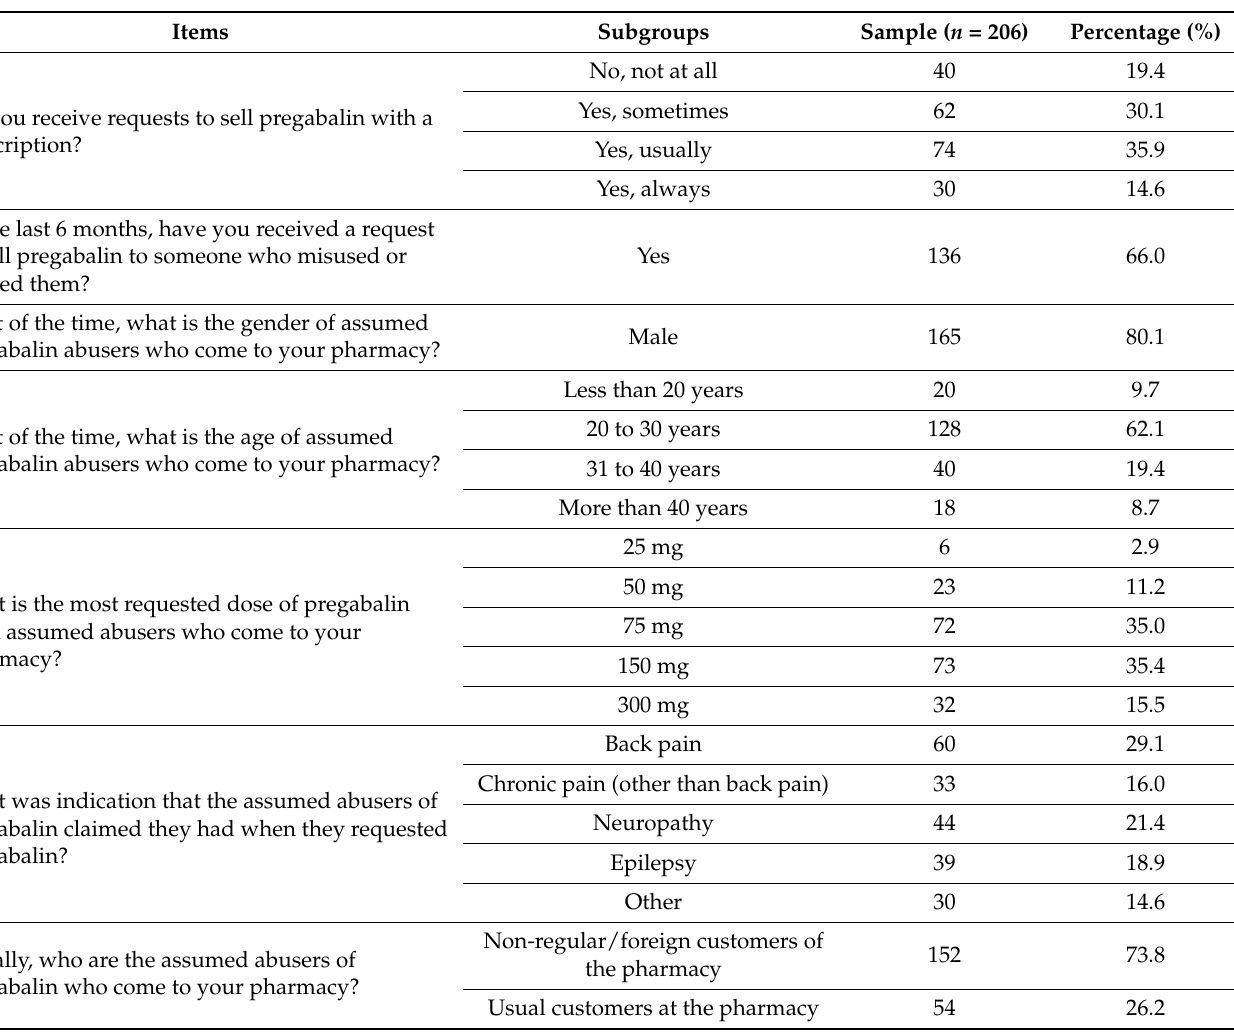
Table 2. Community pharmacists’ perceptions towards customer’s misuse and abuse of